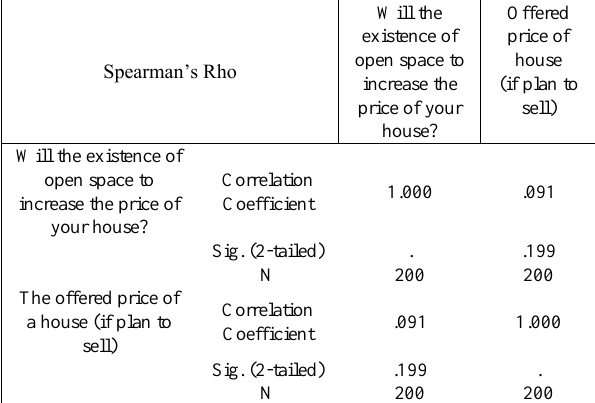
Table 2: Correlation between existence of open space